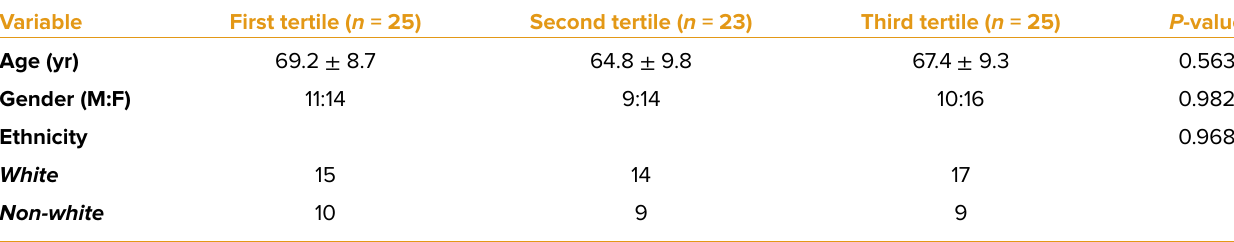
Table 1. Demographic features of the study population according to optic disc size Variable